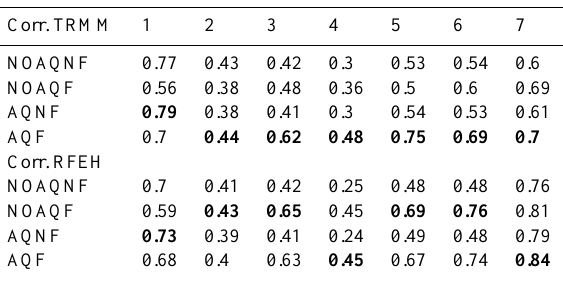
Table 4. Correlations of the river height changes (from 2002 to